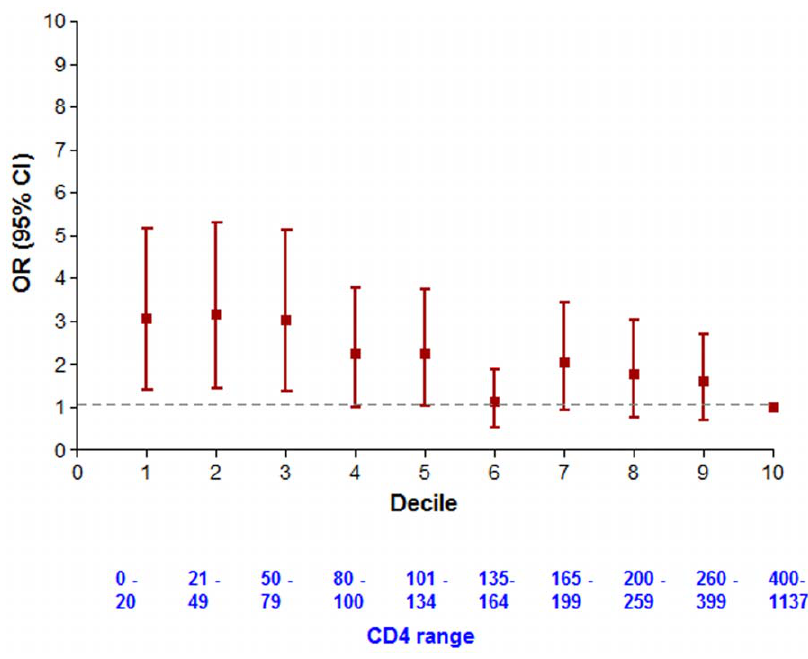
Figure 1. Odds Ratios for Clinically Significant Drug Interaction by CD4 Count Decile.